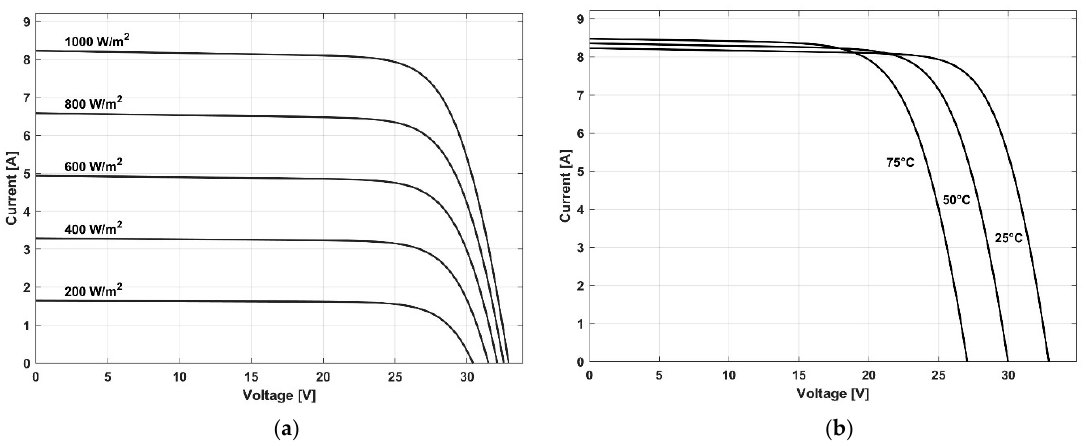
Figure 5. I–V curves for the module KC200GT at different solar irradiance ( a ) and temperature ( b ) of the proposed method.